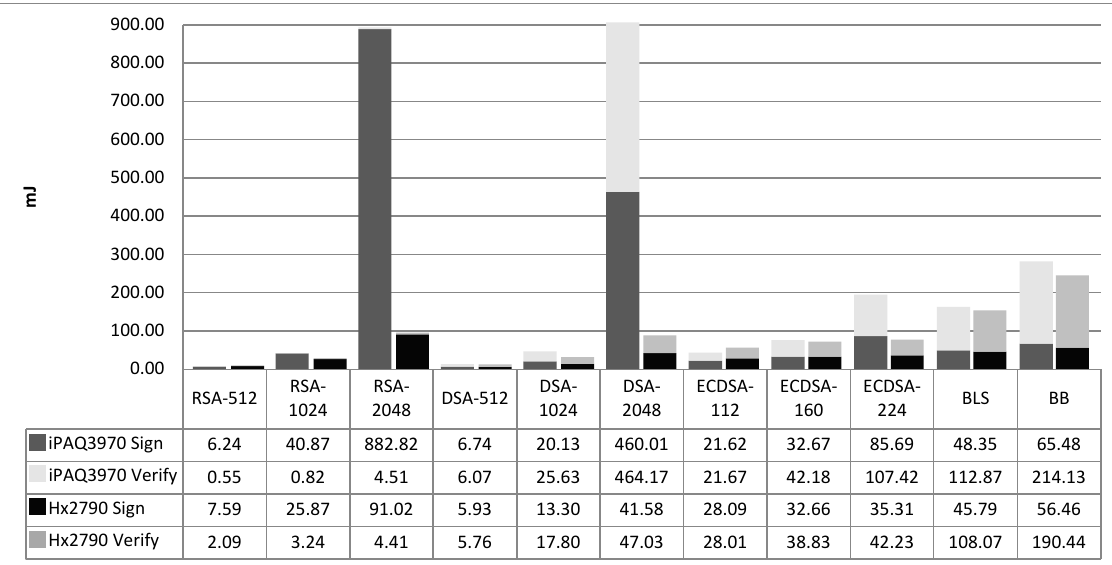
Figure 6. Energy costs of digital signature algorithms.